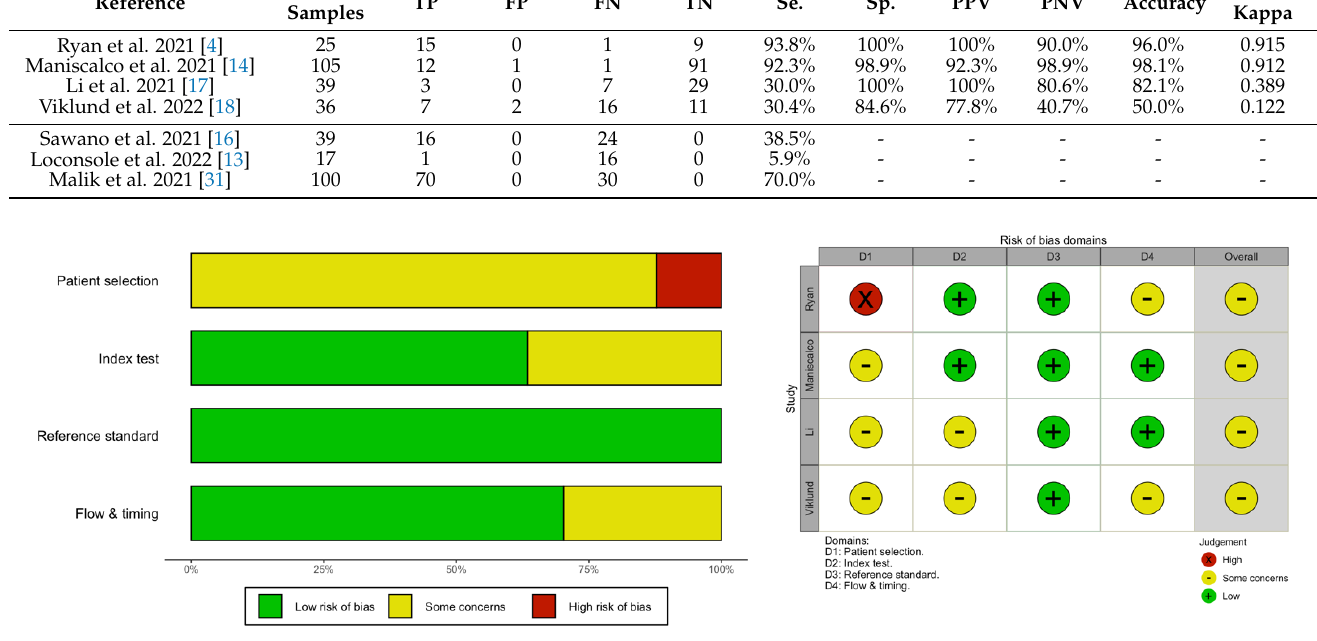
Figure 2. A QUADAS-2 assessment on the risk of bias.